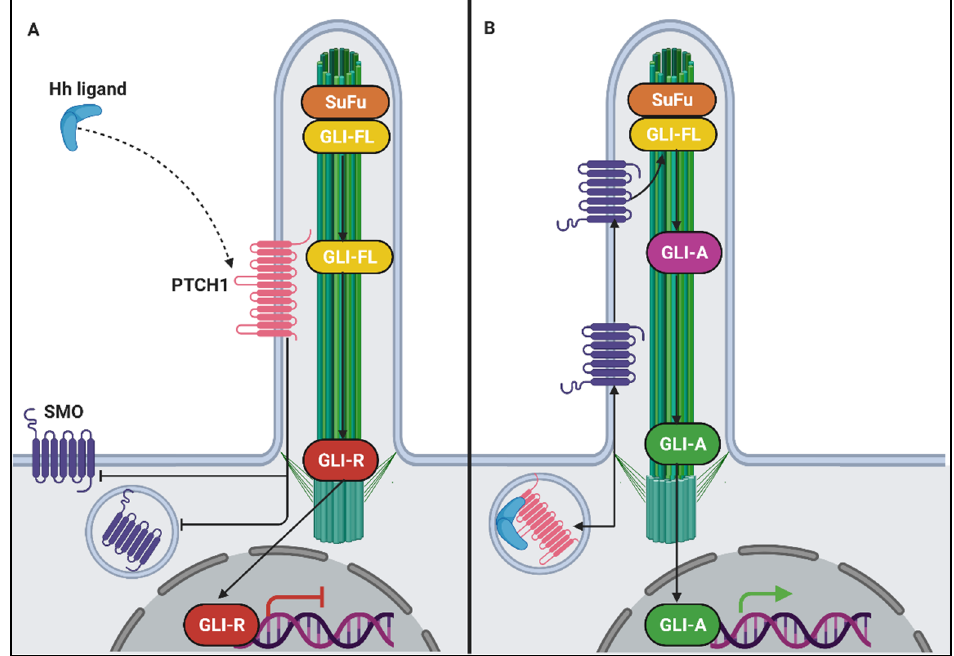
Figure 9. Hedgehog (Hh) signalling: ( A ) In an unbound state, patched (PTCH1) is localised in the cilia. In the absence of bound Hh ligands, full-length GLI family zinc finger 3 (GLI3) protein (GLI-FL) is proteolytically cleaved to form a repressed form of GLI3 (GLI3-R) which represses the expression of downstream genes controlled by Hh pathway. ( B ) When Hh ligands bind to PTCH1, it translocates out of the cilium. Simultaneously, smoothened (SMO), translocates and enriches into the ciliary compartment. SMO activates the GLI transcription factors GLI-A (made of GLI1 and GLI2). GLI-A translocates into the nucleus where its dynamic balance with GLI-R determines the output of downstream Hh genes (Modified and redrawn using BioRender.com [150] ).